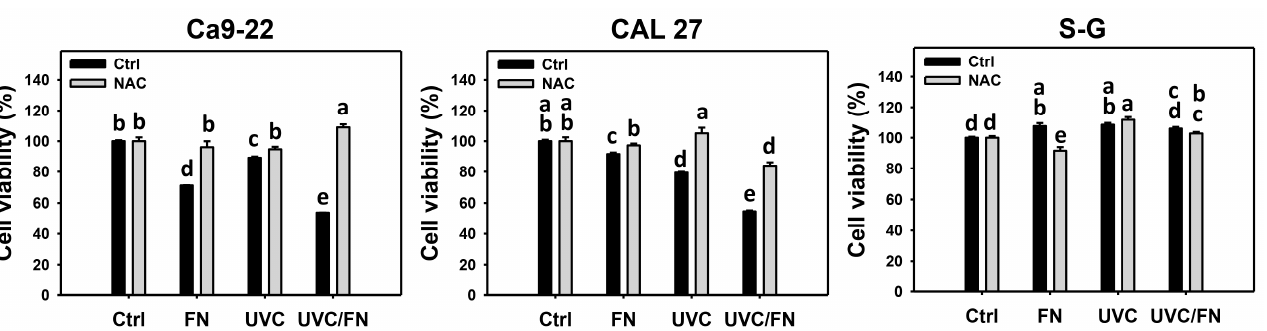
Figure 1. Cell viability determination. There are four kinds of treatment for oral cancer (Ca9-22 and CAL 27) and non-malignant oral (S–G) cells: control, FN (300 μ g/mL), UVC (10 J/m 2 for Ca9-22; 15 J/m 2 for CAL 27 and S–G), and UVC/FN (10 J/m 2 /300 μ g/mL for Ca9-22; 15 J/m 2 /300 μ g/mL for CAL 27 and S–G). NAC indicates that cells were pretreated with 10 mM NAC. Their viabilities were de- termined by MTS assay after 24 h treatment. Data are provided as means ± SD ( n = 3). The low-case letters were assigned by JMP software to determine significant differences. Significant differences were indicated by non-overlapping, low-case letters ( p < 0.05). For the example of Ca9-22 cells, the low-case letters for control, FN, UVC, and UVC/FN, showing “b, d, c, and e” significantly differ from each other because the letters are not overlapping. Moreover, UVC/FN for control and NAC showing “e and a” indicates significant differences. In contrast, the controls for non-treatment and NAC only showing the same letter “b” indicate non-significant results.